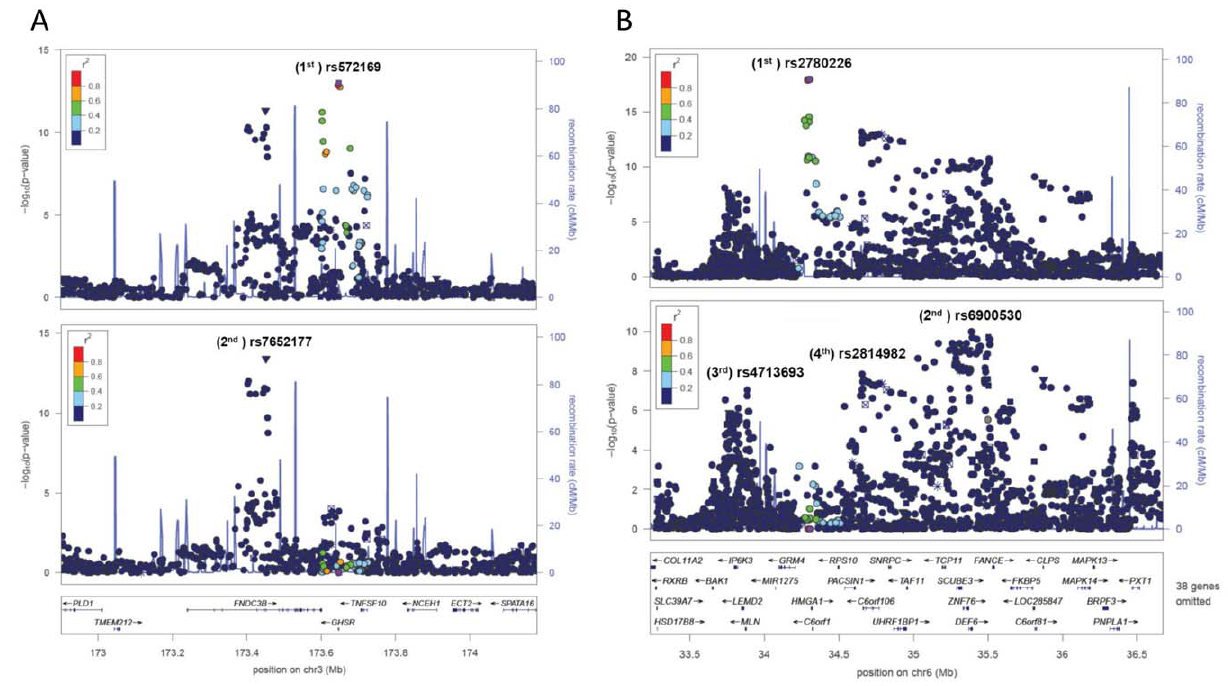
Figure 2. Two example loci with allelic heterogeneity. (A) The GHSR locus included a secondary signal (rs7652177) after accounting for the primary signal (rs572169). (B) The HMGA1 locus had a more complicated pattern of allelic heterogeneity; with significant secondary, tertiary and quaternary signals after multiple rounds of conditioning (only the first round of conditioning is shown). The secondary p-values (bottom plots) conditioning on the primary SNP were estimated from GIANT summary data using the analytical approach described in main text.